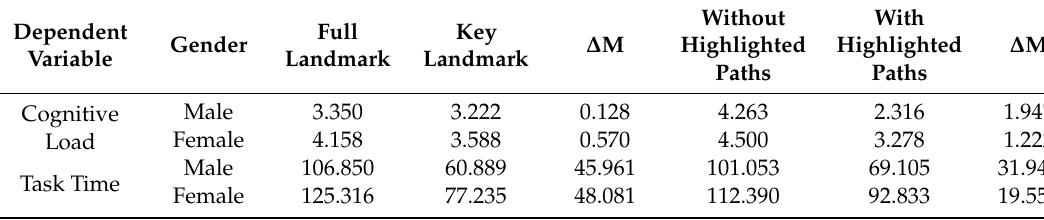
Table 5. Changes in cognitive score mean and task time